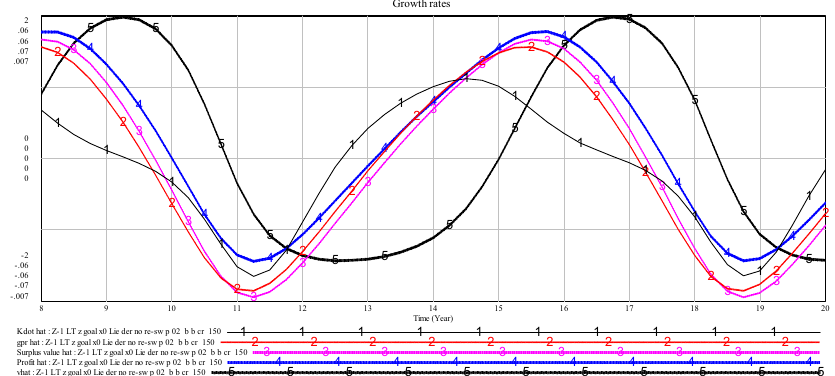
Fig. 7 Growth rates of investment (1), profit rate (2), surplus value (3), profit (4) and employment ratio (5) over the growth cycles along the limit cycle (related to the first AHB) in L-1, years 8–20